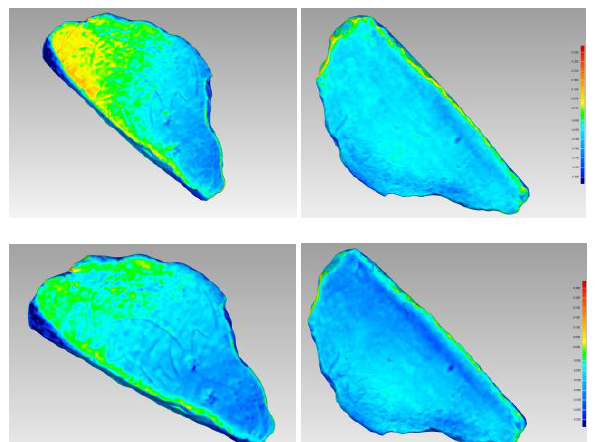
Figure 11: Results on the coloured replica. Above: the first test; below: the second